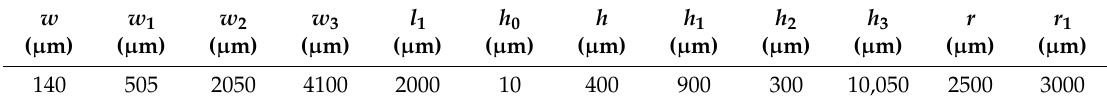
Table 1. The optimized structural parameters for sensor-head.